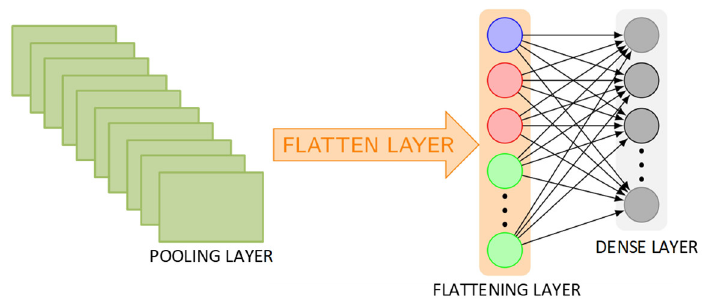
Figure 4. Flattening layer working.